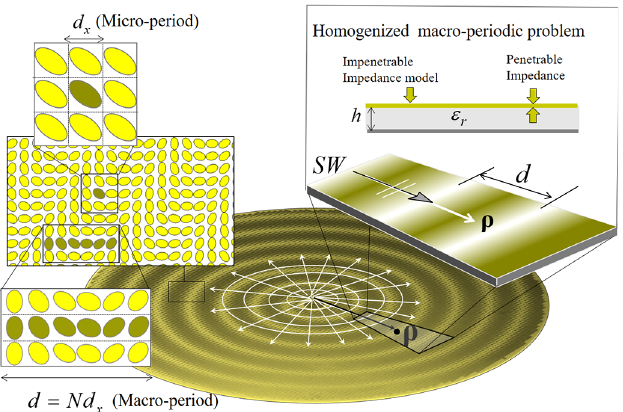
Fig. 1. MTS antenna and illustration of the double-scale periodicity (left hand zoom) and of the homogenized impedance models (rigth hand side zoom).